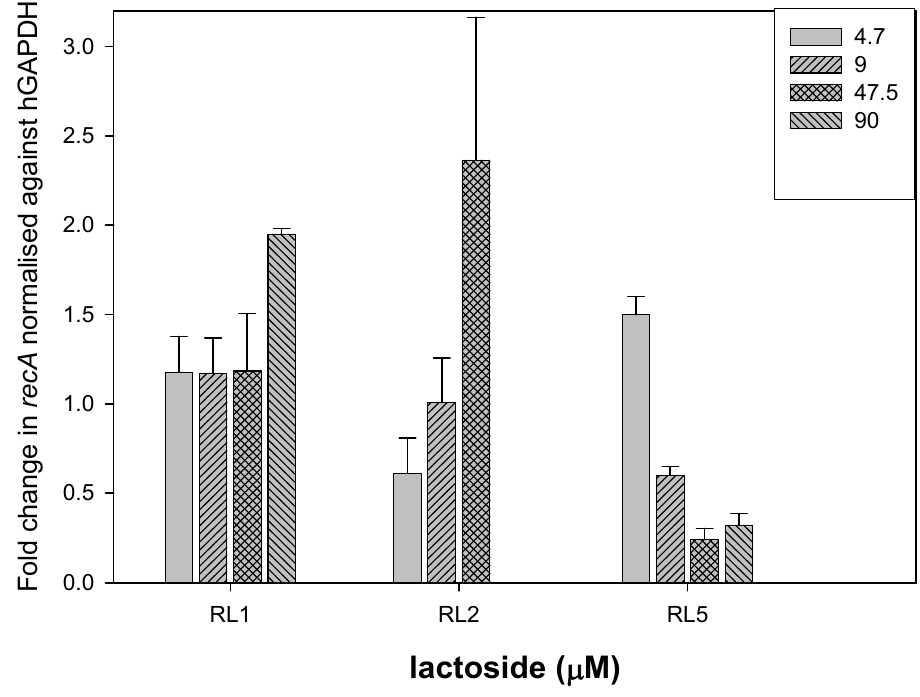
Figure 2. Inhibition of binding of B. multivorans to lung epithelial cells. Bacteria were pre-incubated with lactosides for 30 min prior to infection of lung epithelial cells. Bars represent the fold change in binding of bacteria to lung epithelial cells relative to uninhibited solvent